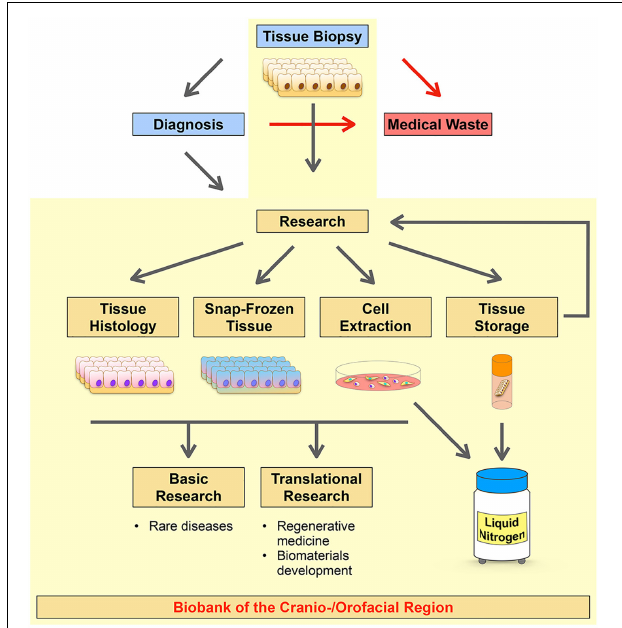
FIGURE 1 | Schematic diagram summarizing the strategy of our CFA biobank. The Pediatric Surgery Division, Children’s Hospital, Bern, and the Dental School, University of Bern are responsible for tissue excisions and, if required, for further diagnostic analyses of the biopsies (blue boxes). Usually, tissues from the cranio-/orofacial region are discarded after their initial excision (no diagnosis required) or after their diagnostic analysis (medical waste, red box). The research laboratory (Laboratory for Oral Molecular Biology, University of Bern) collects such specimens and processes them in order to create a living cell repository of patient-derived cells (Cell Extraction). After isolation of the cells, if the tissue size allows it, the remaining tissue remnants are (1) stored in freezing medium in the liquid nitrogen tank for future processing and new cell extractions (Tissue Storage), (2) formalin-fixed and paraffin-embedded (FFPE) for histological analyses (Tissue Histology), and (3) snap-frozen for future tissue RNA and/or DNA extractions (Snap-Frozen Tissue). These patient-derived resources can be used for several downstream applications in discovery and translational research projects. Our workflow is highlighted in